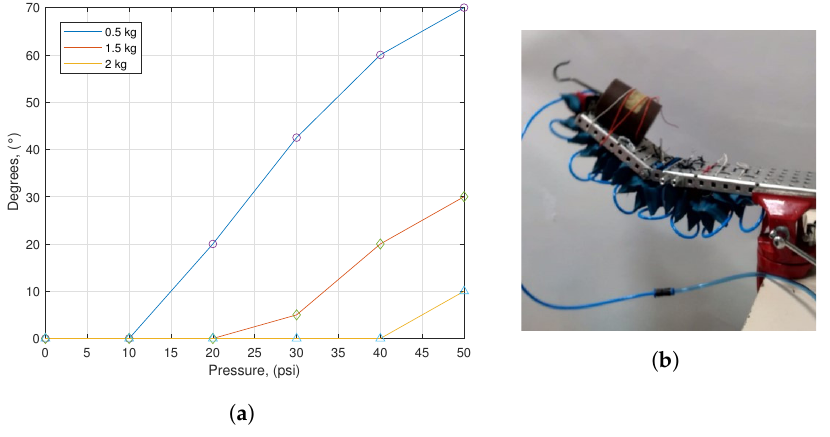
Figure 8. Range of Motion test of FISAs when lifting 0.5 kg, 1.5 kg, and 2 kg. ( a ) Pressure vs. Degrees test. ( b ) FISAs and weights